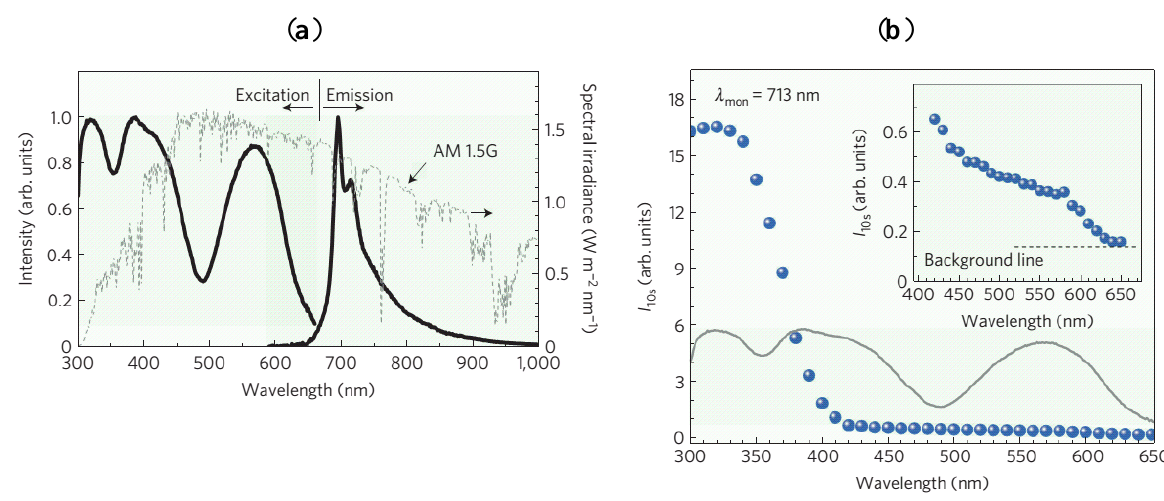
3. ( a ) Excitation and emission spectrum of Zn ( b ) Effectiveness of excitation wavelength (energy) for persistent luminescence of Zn Ga Ge O :0.5%Cr 3+ . The afterglow intensity after 10 s is monitored as a function of 3 2 2 10 the excitation wavelength (Reprinted with permission from [2]).